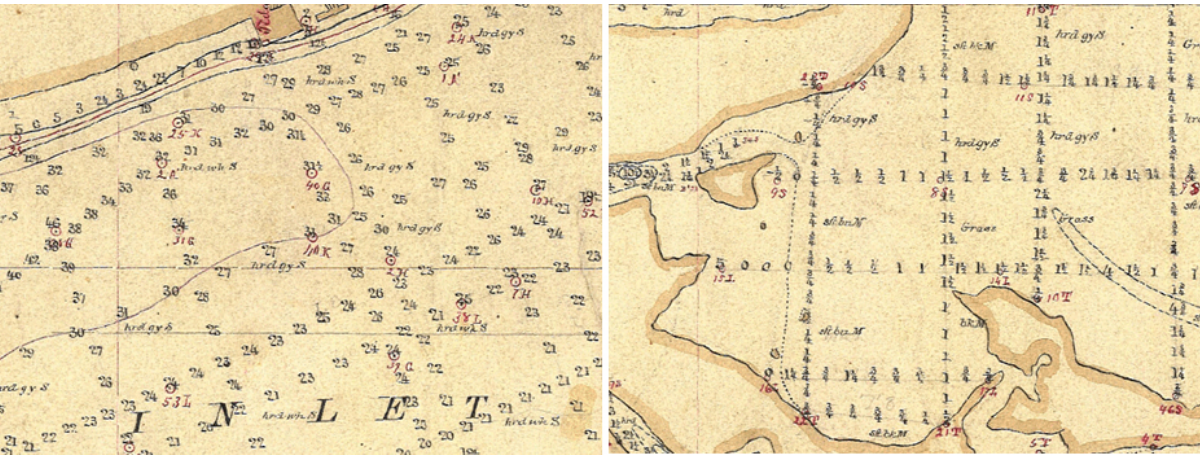
Figure 3. Detail view of two portions of the 1877 survey dataset (left panel) at Rockaway Inlet (at bottom left of Figs. 1 and 2) and (right panel) a shallow bay area with mud, sand, and grass areas (Maynard, 1877). Shown are measured depths (in feet) and bottom